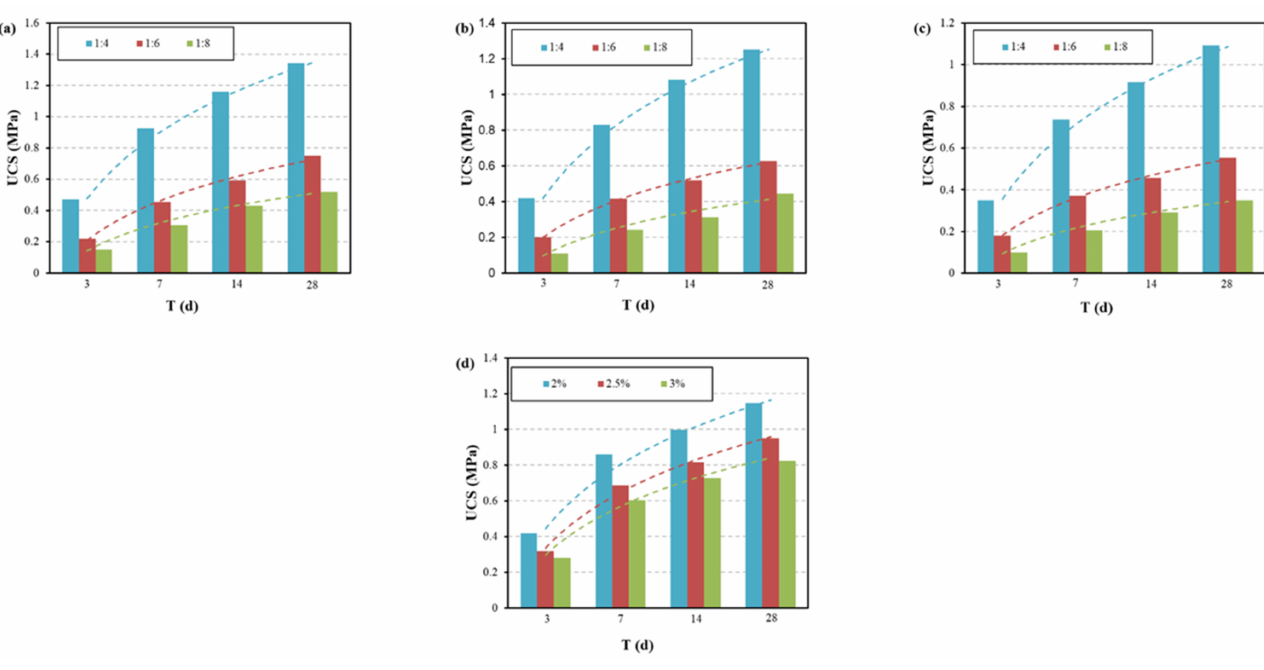
Figure 10. Relationships between T and the UCS of FCPB. ( a ) SC = 76%, FC = 1.5%; ( b ) SC = 74%, FC = 1.5%; ( c ) SC = 72%, FC = 1.5%; and ( d ) SC = 76%, CTR = 1:4.